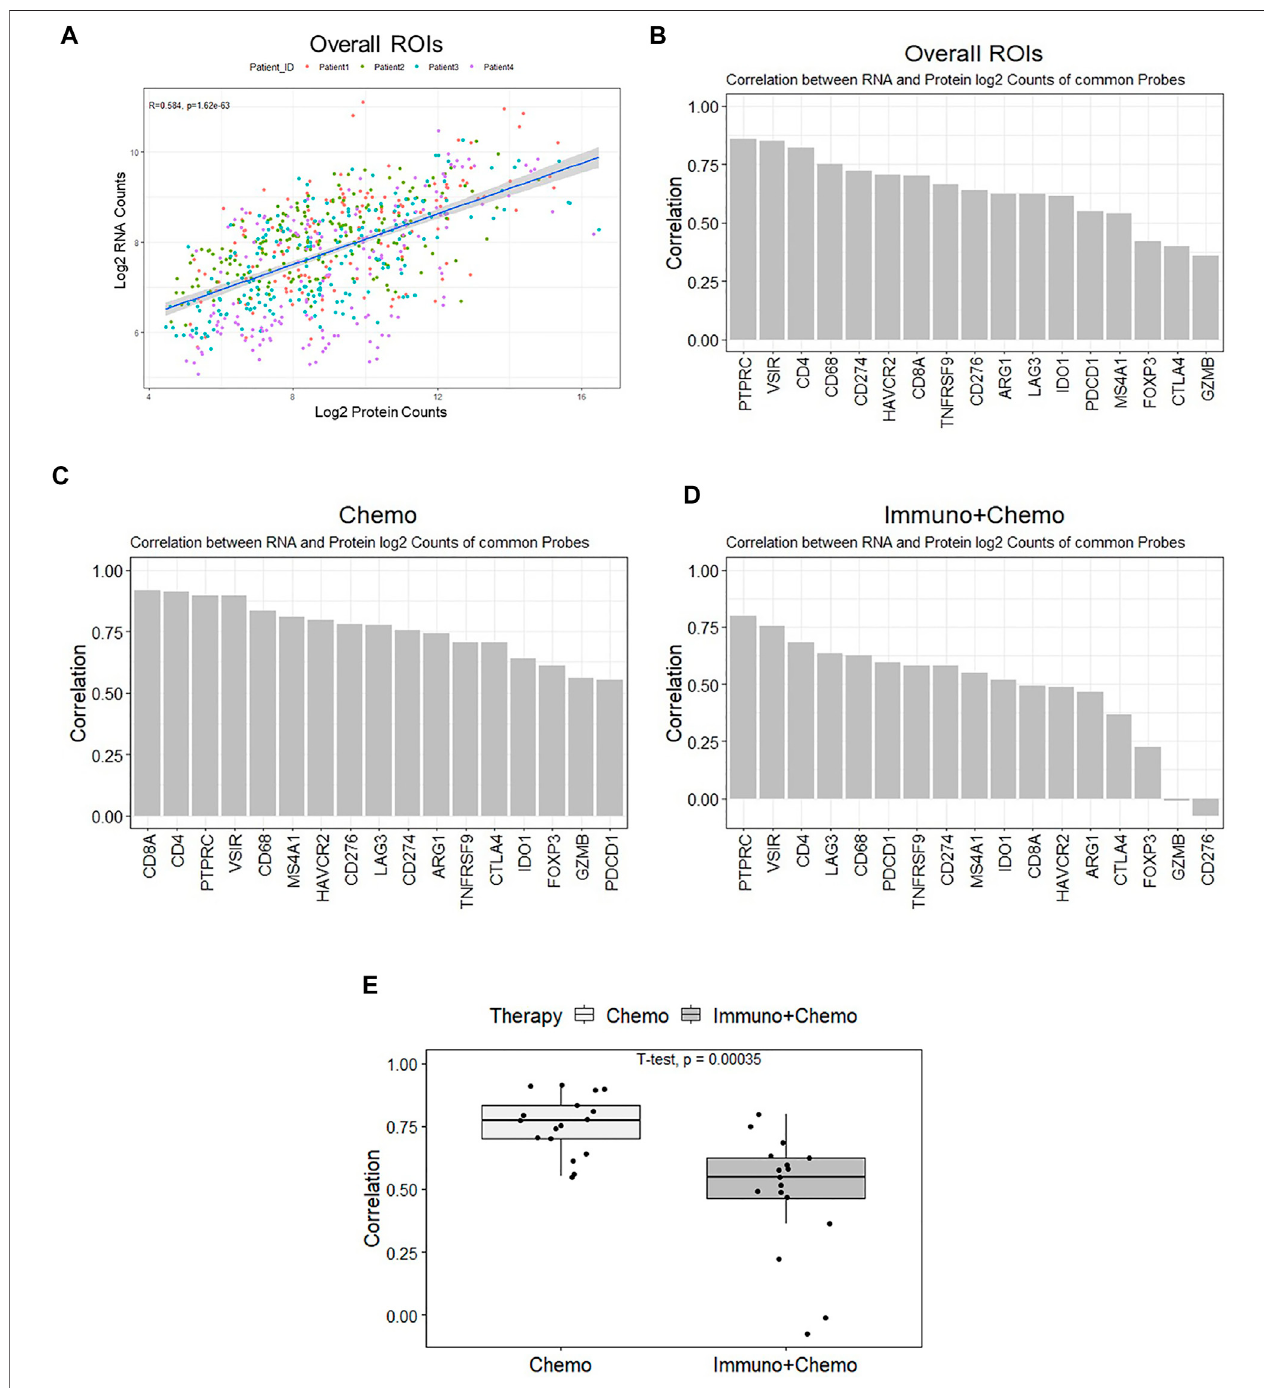
FIGURE 7 | All ROI-based correlation analyses of the 17 common mRNA and protein. (A) Protein (x-axis) and mRNA (y-axis) expression counts were log- transformed and plotted. The correlation coef fi cient is 0.57 ( p < 0.05), and colors denote individual patients. (B) Ranked bar chart of common protein and mRNA correlationofindividualtargetsbasedonallROIs. (C,D) RankedbarchartsofcommonproteinandmRNAcorrelationofindividualtargetsforchemoandchemo/immune patient groups. (E) Boxplot of individual ROI correlation based on common genes between therapies.